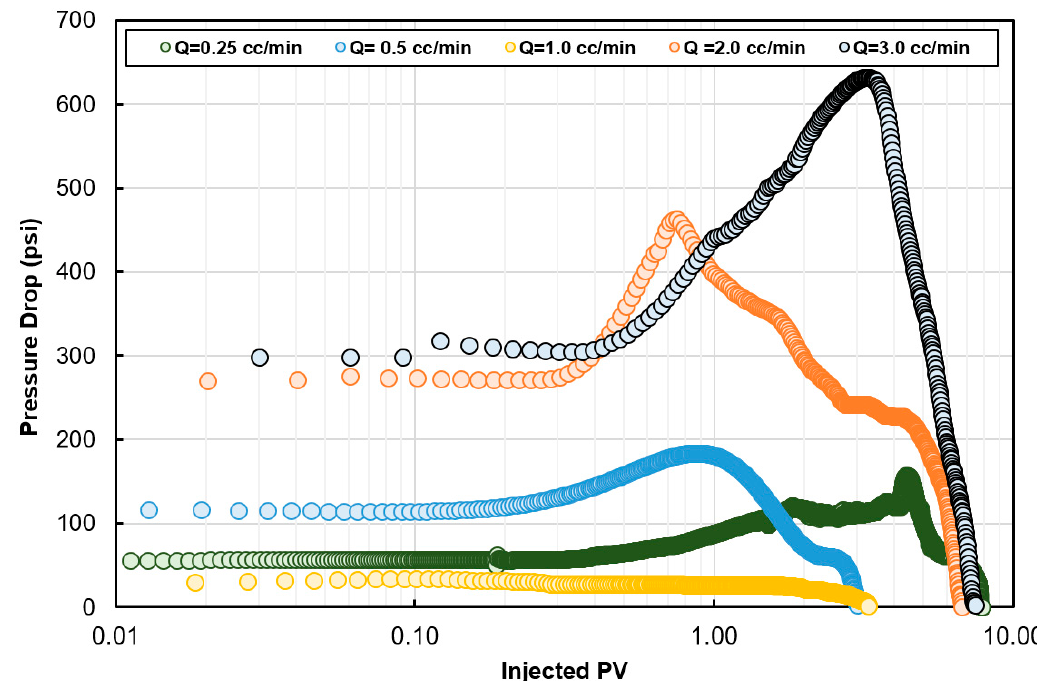
Figure 15. Pressure drop as a function of injected pore volumes during injection of 20 wt% GLDA / SW (pH = 3.8) at 250 °F at different injection rates.